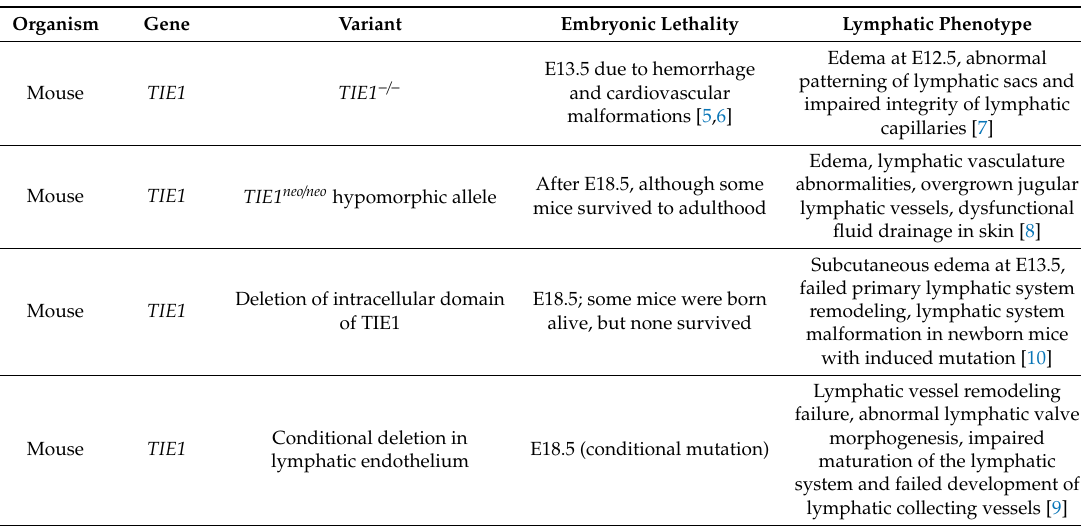
Table 1. Phenotype of TIE1 mouse